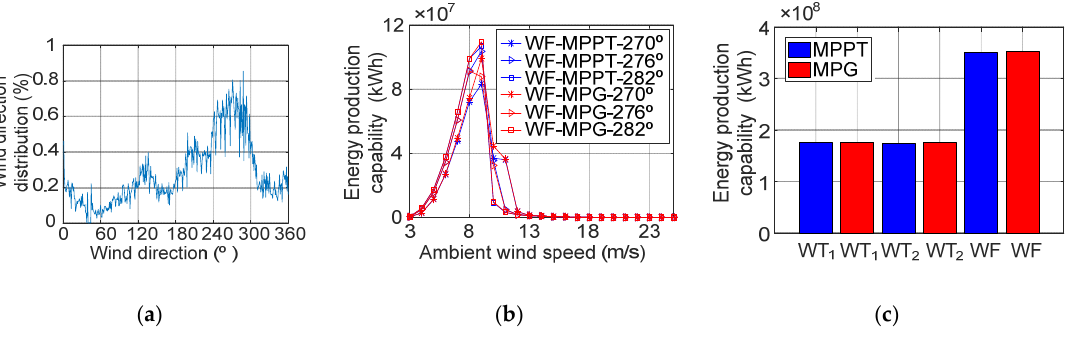
Figure 13. Energy production comparison between the MPPT method and the MPG method considering the field wind direction: ( a ) Wind direction distribution; ( b ) Energy production of the wind farm at typical wind directions of 270°, 276° and 282°; ( c ) Total energy production of the wind farm.